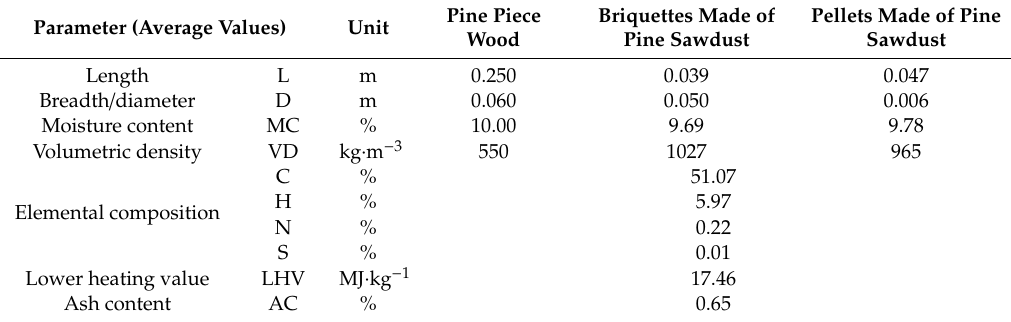
Table 1. Physical and chemical parameters of the solid biofuels used (in working